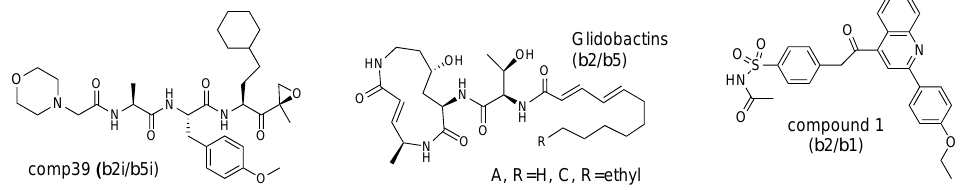
Figure 10. Dual inhibitors of β 2/ β 5 and β 2/ β 1 Figure 10 . Dual inhibitors of β 2/ β 5 and β 2/ β 1 sites.